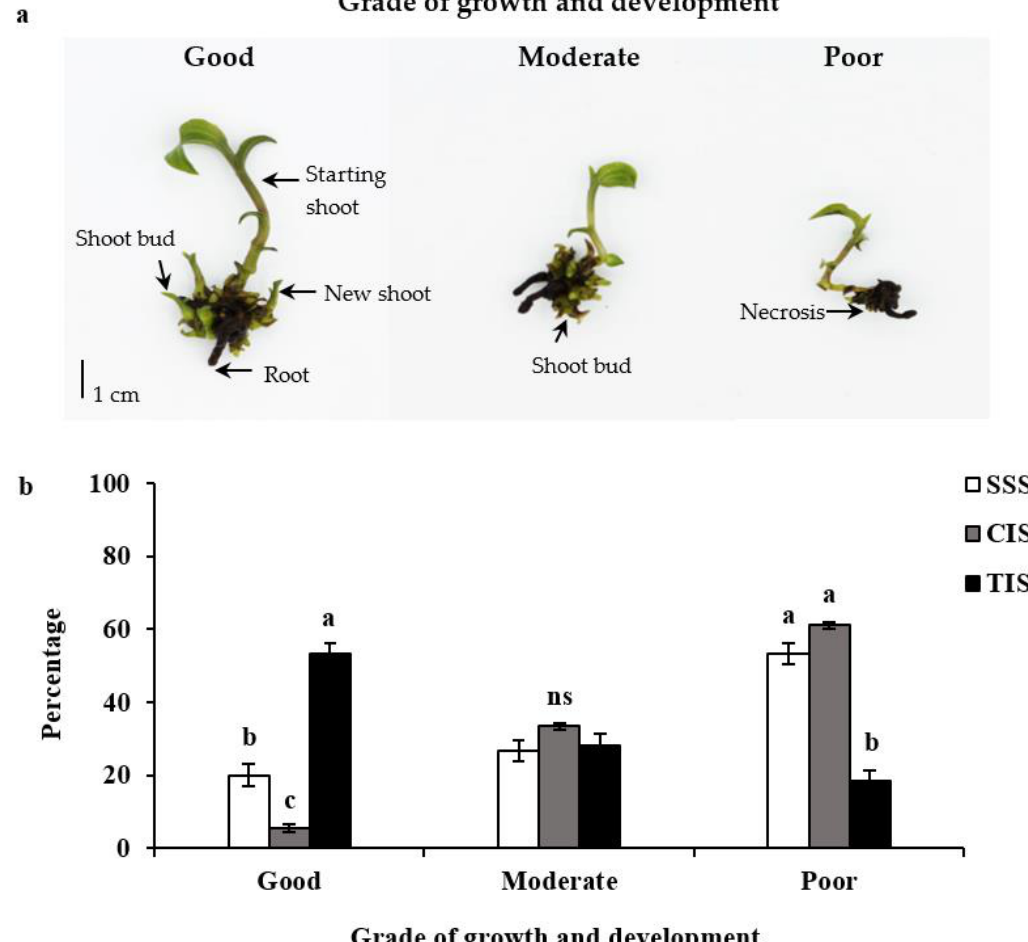
Figure 2. Classifying system for growth of Epipactis flava plantlets ( a ) and comparative effects of culture systems on growth of Epipactis flava plantlets after four weeks of culture ( b ). Results represent the mean ± SE of three replications from 20 explants. Different letters within the same grade of growth were significantly different at p ≤ 0 . 05 according to Duncan’s Multiple Range Test ( DMRT ) . Table 1. Effect of culture systems on growth and development of Epipactis flava plantlets for four weeks of culture.